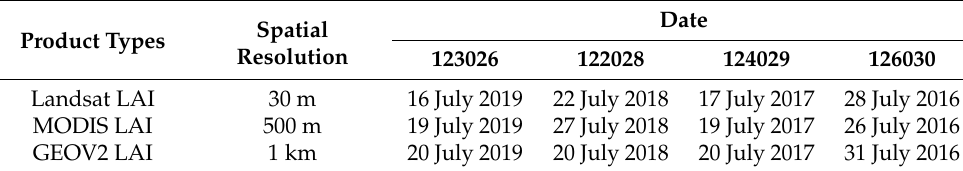
Table 3. The date of different products used in this study.